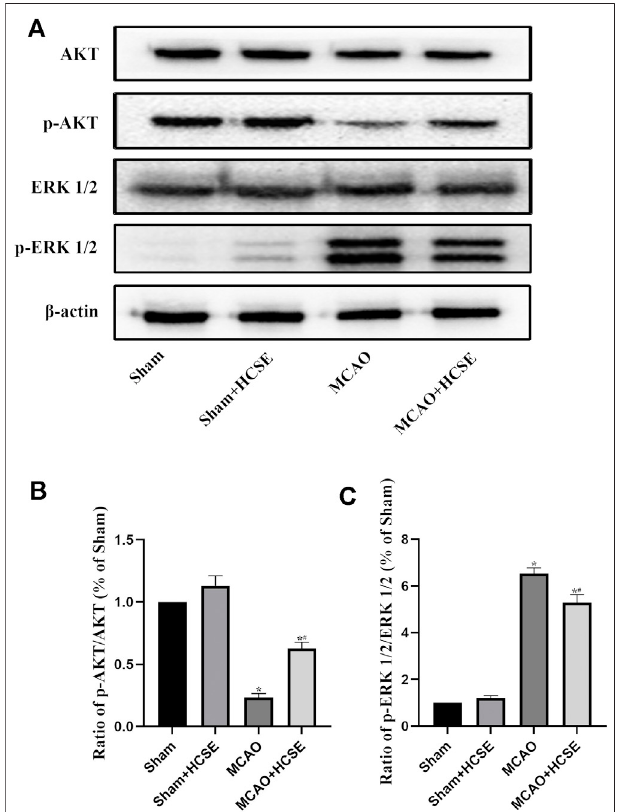
FIGURE 7 | Changes in the levels of proteins related to the AKT/p-AKT/ ERK1/2/p-ERK 1/2 signaling pathway in the hippocampus. (A) Western blottingofrelated proteins. (B) Theratioofp-AKT/AKT. (C) Theratioofp-ERK 1/2/p-ERK1/2.( n =7pergroup;* p < 0.05,signi fi cantlydifferentfromthe corresponding Sham group, # p < 0.05, signi fi cantly different from the MCAO